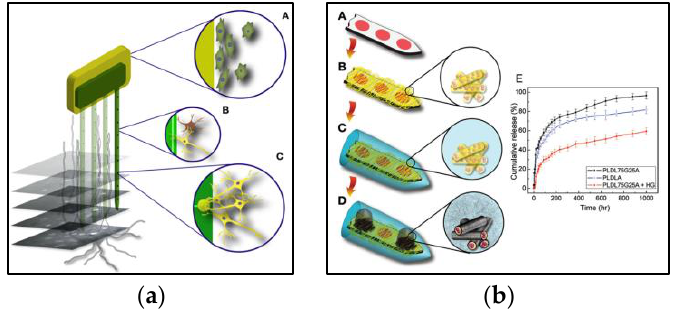
Figure 3. ( a ) Graphical representations of common surface modification strategies, reprinted with permission from Marin et al. [81]. An optimal surface should consist of an insulation layer that facilitates the adsorption of proteins, adhesion of fibroblast, and adhesion of neurons and glial cells without macrophage reaction and a microelectrode surface that attracts neurons without adhesion of fibroblasts or macrophage reaction; ( b ) Graphical representation of selective coatings of different bioactive materials on a neural probe, reprinted with permission from Abidian et al. [116]. Drug-loaded biodegradable nanofibers are encapsulated by a biocompatible alginate hydrogel as the insulation layer and poly(3,4-ethylenedioxythiophen) (PEDOT) is electrochemically polymerized on the microelectrode.